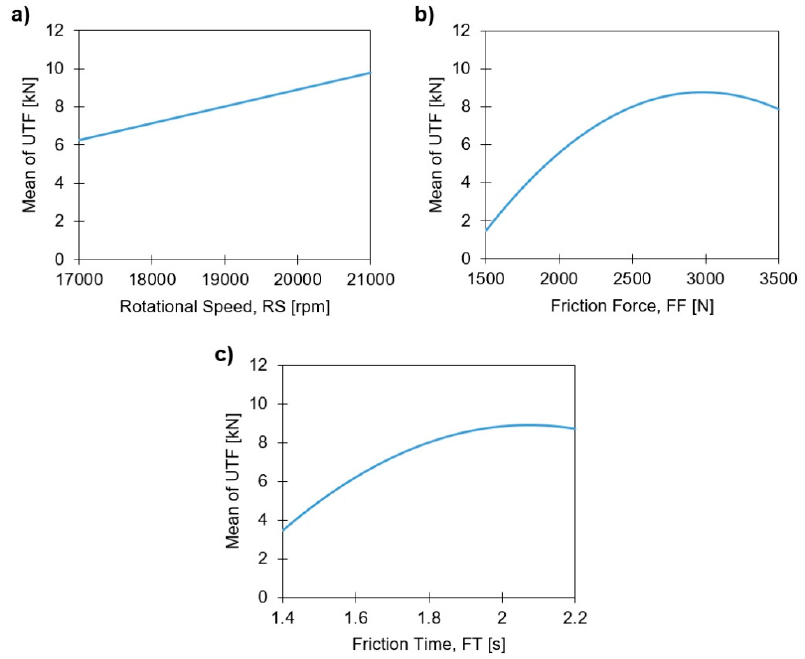
Figure 16. Main effects plots of linear model terms for the UTF response, with: ( a ) Rotational Speed; ( b ) Friction Force; and ( c ) Friction